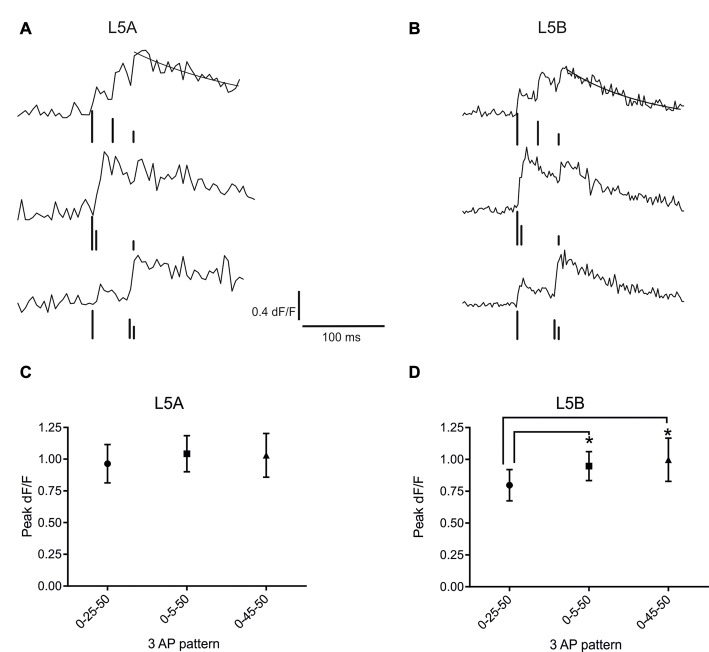
bAP evoked calcium responses induced by artificial firing AP patterns. (A) An example of the bAP-evoked calcium responses evoked by the three different 3AP patterns in a L5A-st cell (measured at 68 μm from the soma). The peak calcium response was calculated by fitting a standard exponential to the decay phase (black line). The black bars illustrate the time point of AP stimulation. The upper trace corresponds to the 0–25–50 ms stimulus, middle trace: 0–5–50 ms and the lower trace: 0–45–50 ms. The vertical lines are drawn at different heights, for the purpose of clarity. (B) Representative example of the bAP-evoked calcium responses measured in a L5B-tt cell (154 μm from the soma) and induced by the same three 3AP patterns used in (A). Analyzing the three different 3AP patterns separately shows that in L5A cells (C) there was no effect of a high frequency component (200 Hz interspike interval, ISI) in the 3AP trains (averaged from dendritic spots at 40–254 μm), whereas in L5B cells (D) the two 3AP patterns with a high frequency component evoked a larger calcium response compared to the 3AP pattern with a 40 Hz ISI (averaged from dendritic spots at 57–168 μm). *P < 0.05.